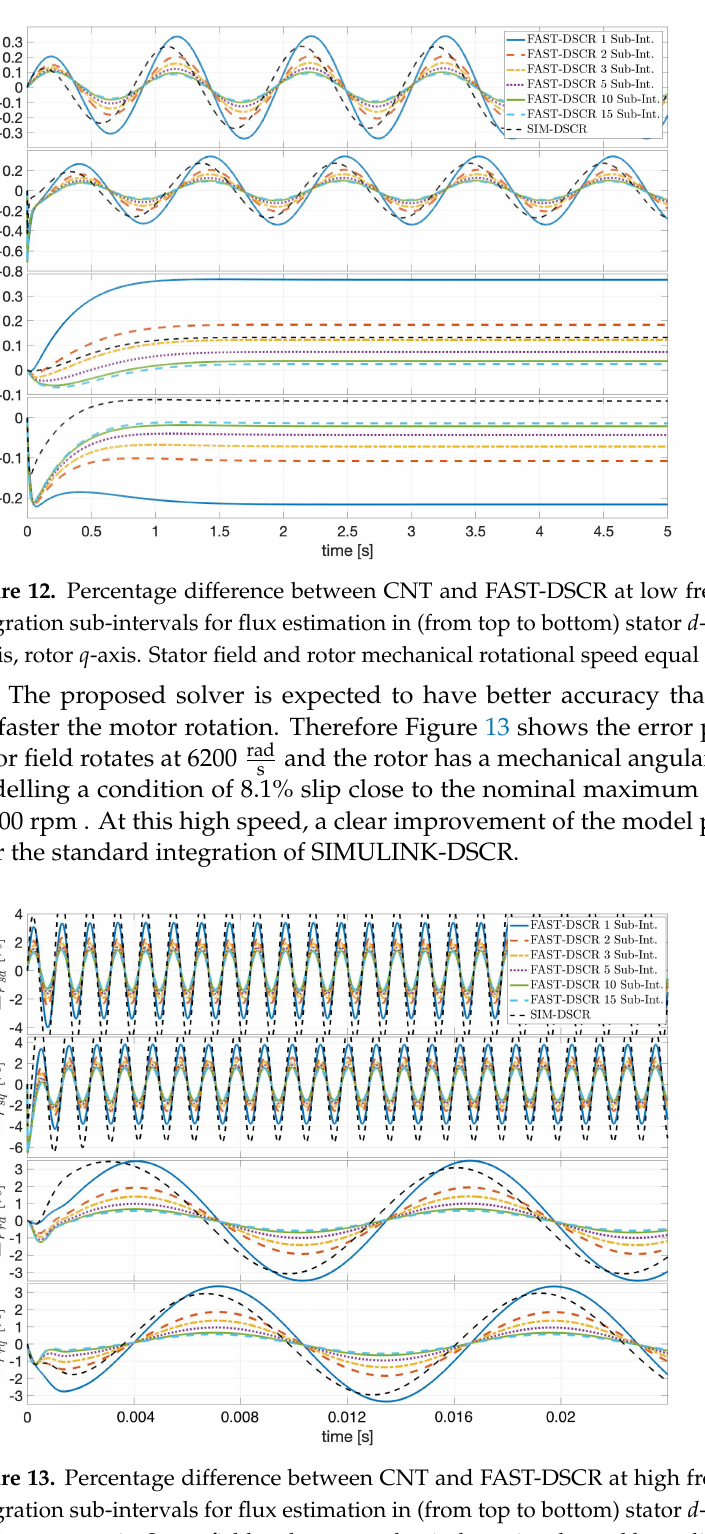
Figure 13. Percentage difference between CNT and FAST-DSCR at high frequency increasing the integration sub-intervals for flux estimation in (from top to bottom) stator d -axis, stator q -axis, rotor d -axis, rotor q -axis. Stator field and rotor mechanical rotational speed have different values, 6200 and 5700 rad s